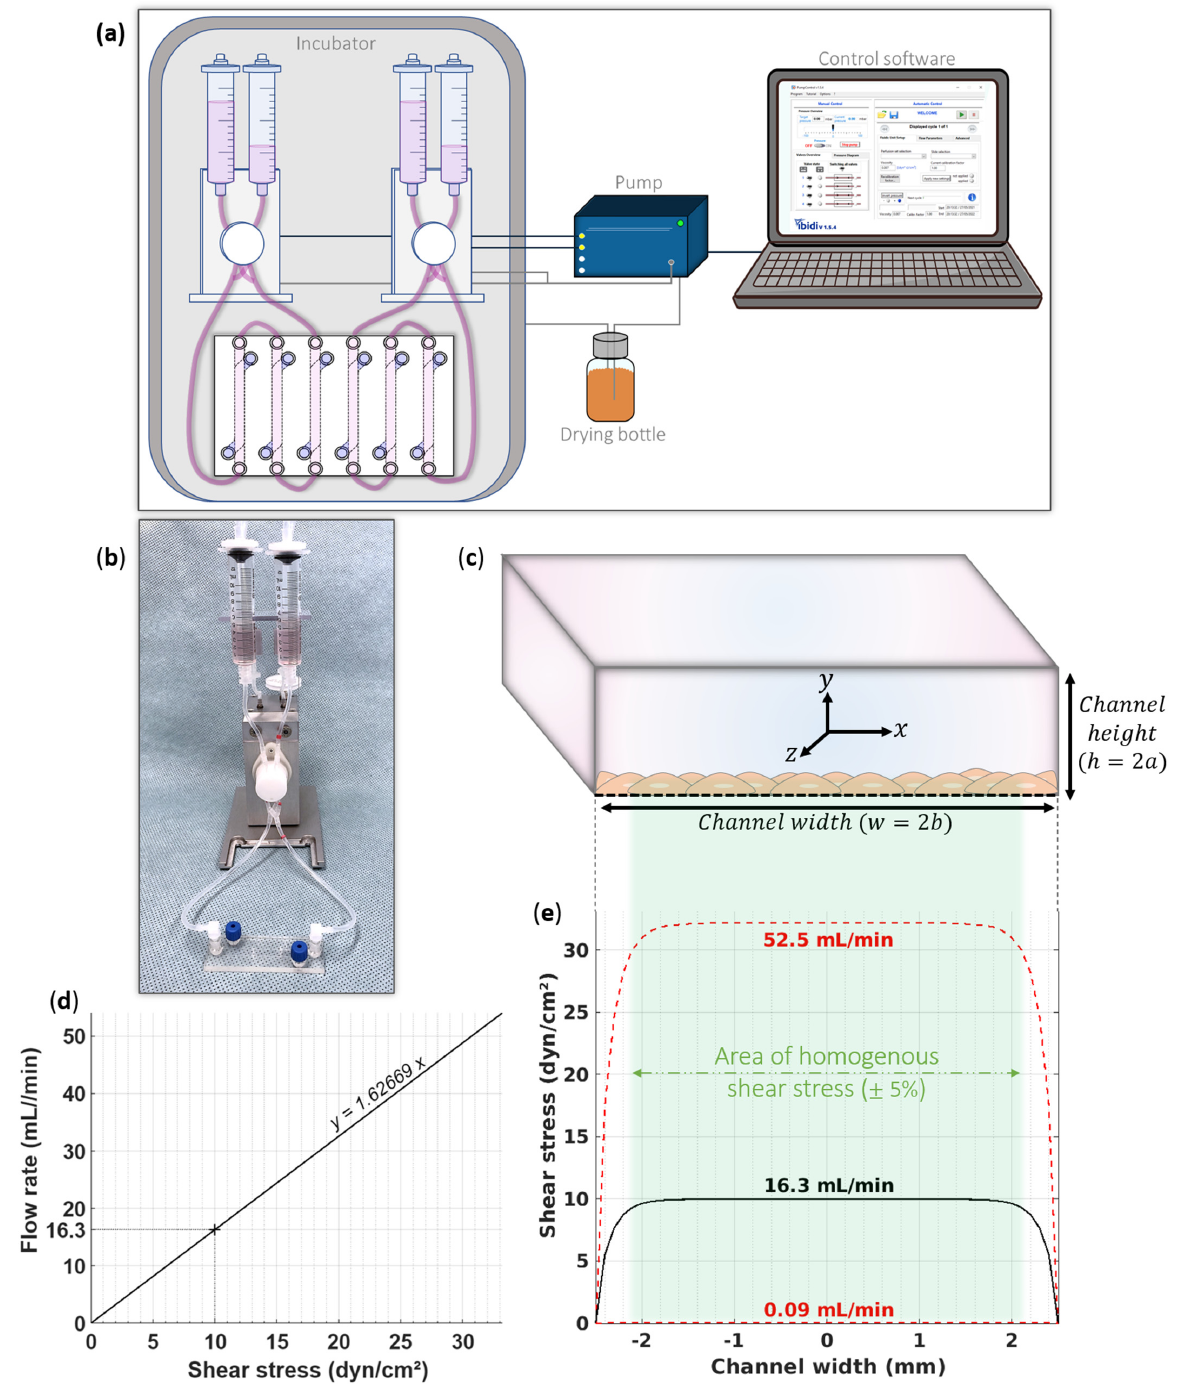
Figure 2. Fluidic setup. ( a ) Representation of the fluidic equipment for our barrier device in well plate format. The Ibidi pump is controlled by the specific software and simultaneously drives two fluidic units with independent flow parameters. Two fluidic units connect six channels. ( b ) Picture of our barrier device in microscope slide format connected to a fluidic unit. ( c ) Illustration of the orthonormal coordinate system necessary for the flow calculations in the channel cross section. ( d ) Calibration curve of the flow rate to implement according to the intended shear stress on the cell monolayer. For 10 dyn · cm − 2 in our barrier device, we must configure a flow rate of 16.3 mL · min − 1 . This calculation depends on the geometry of the seeding channel and parameters of the culture medium perfused. ( e ) Prediction of area of uniform shear stress along the channel width on the cell monolayer. Ibidi pump system can provide flow rates from 0.09 to 52.5 mL · min − 1 (corresponding to a range of 0.055 to 32.3 dyn · cm − 2 ). Shear stress is distributed homogenously on 82% of the channel